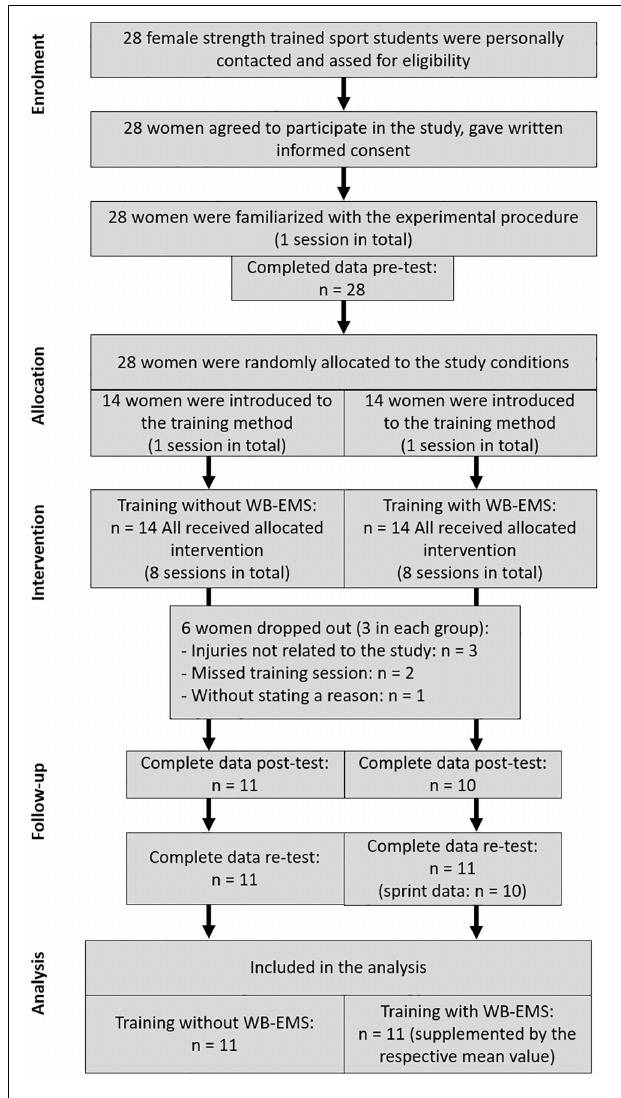
FIGURE 1 | Participants flow through the study [adapted from Moher et al.